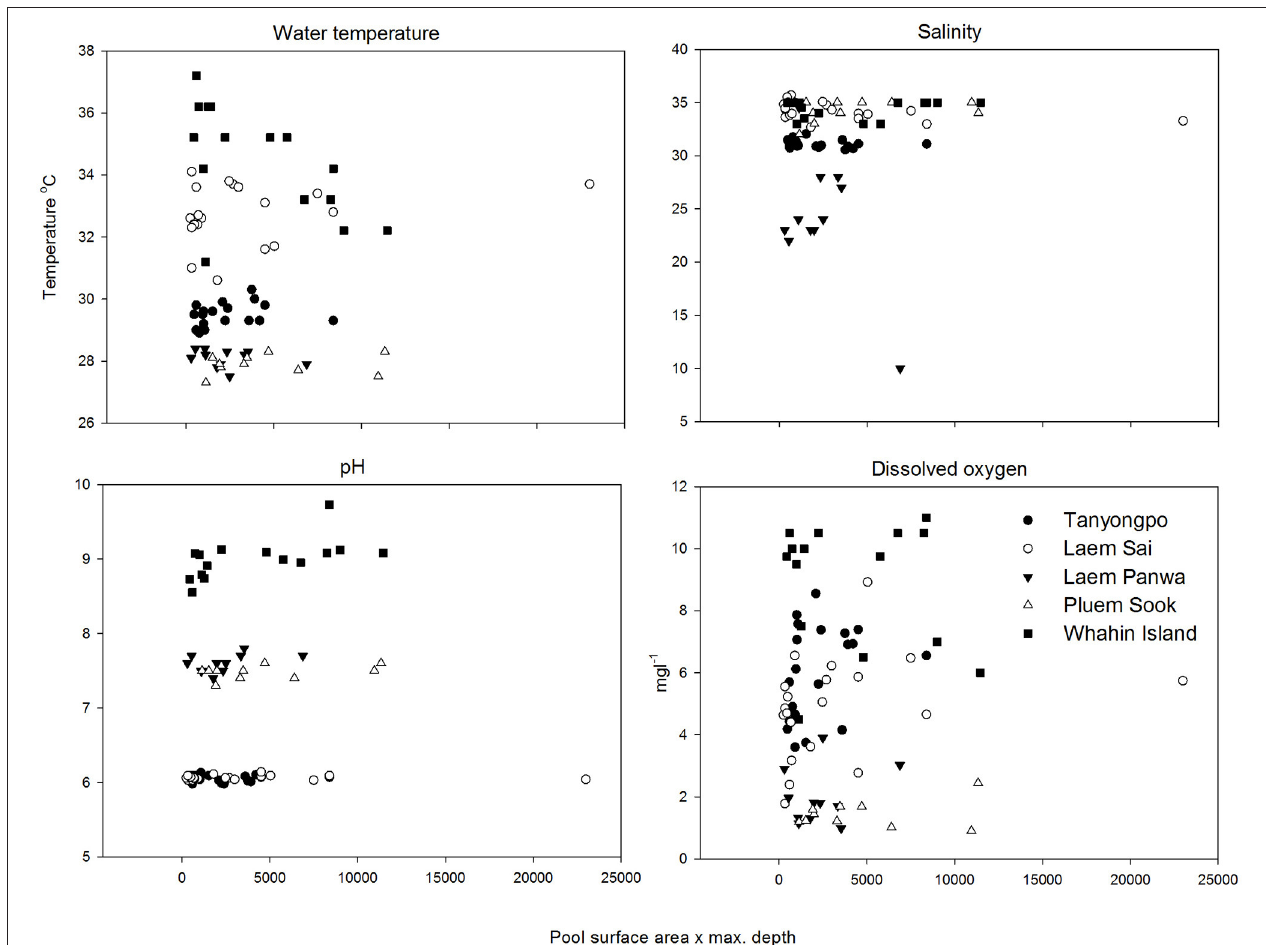
FIGURE 2 | Variation in water temperature, salinity, pH, and dissolved oxygen with pool size dimensions (depth × surface area) from five study shores. Note that none of the physico-chemical parameters were significantly correlated with pool size dimensions.